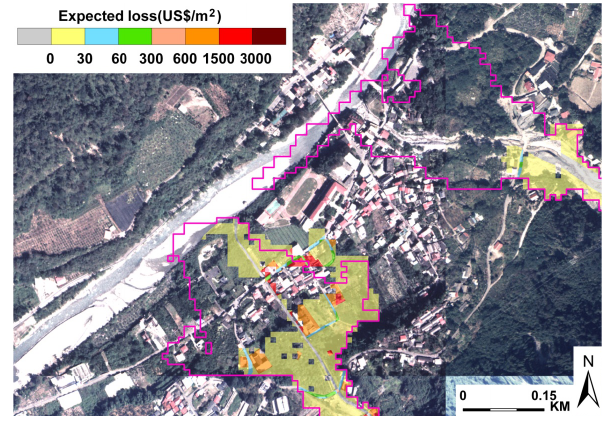
Fig. 8. Map showing the expected total loss caused by debris flows of the Nos. 1 and 2 Torrents for an event with 50-year return period Figure 8. Map showing the expected total loss caused by debris flows of the No. 1 and No. 2 3 after mitigation structures were installed and evacuation measures Torrents for an event with 50-year return period after mitigation structures were installed and 4 were implemented. The pink line is the boundary of the simulated evacuation measures were implemented. The pink line is the boundary of the simulated debris 5 debris flow deposits in Fig. 2. flow deposits in Fig. 2. 6